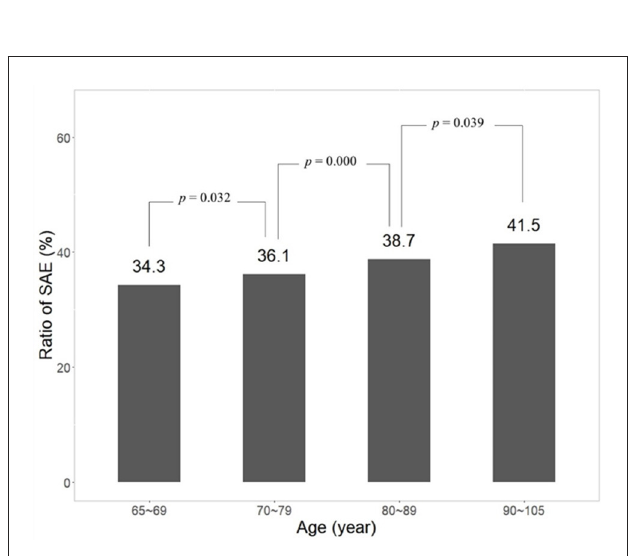
FIGURE7 Significant increase of SAE incidence related to higher